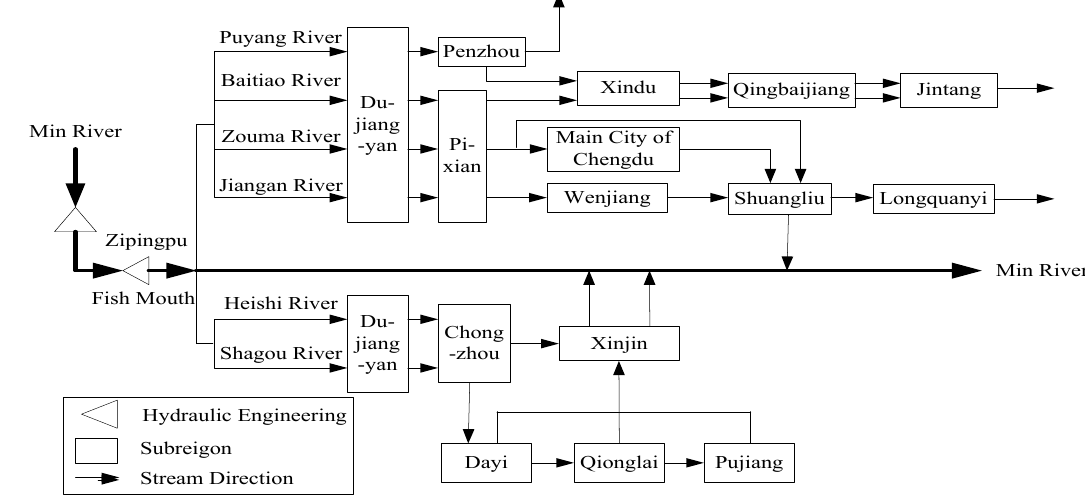
Fig. 5 Conceptual water resources network of